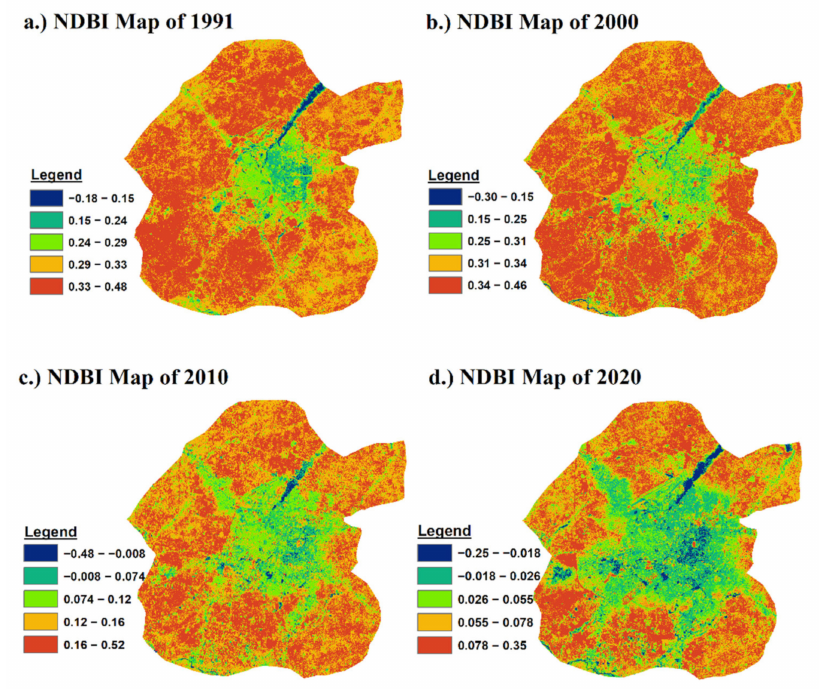
Figure 10. NDBI Maps of Kano Metropolis in ( a ) 1991, ( b ) 2000, ( c ) 2010, and ( d )